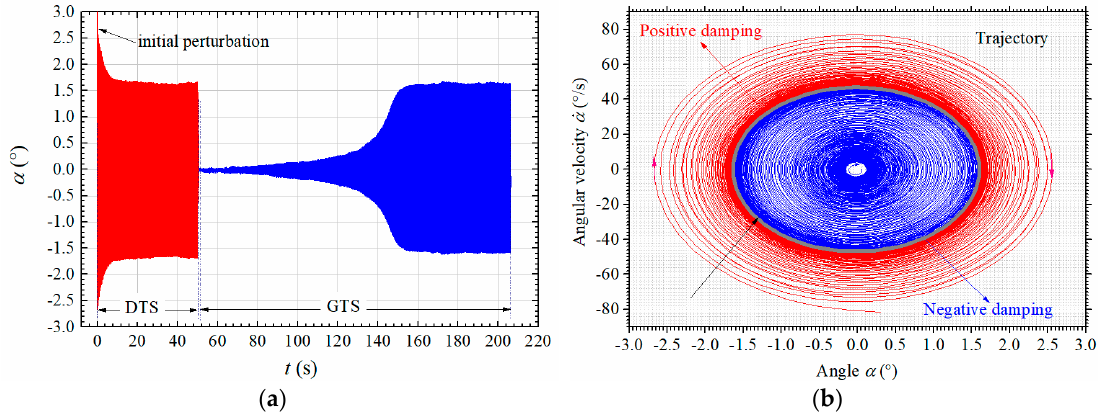
Figure 12. Typical post-critical LCO under different initial perturbations (Case A1, U * = 3.456). ( a ) Time history; ( b ) phase diagram.